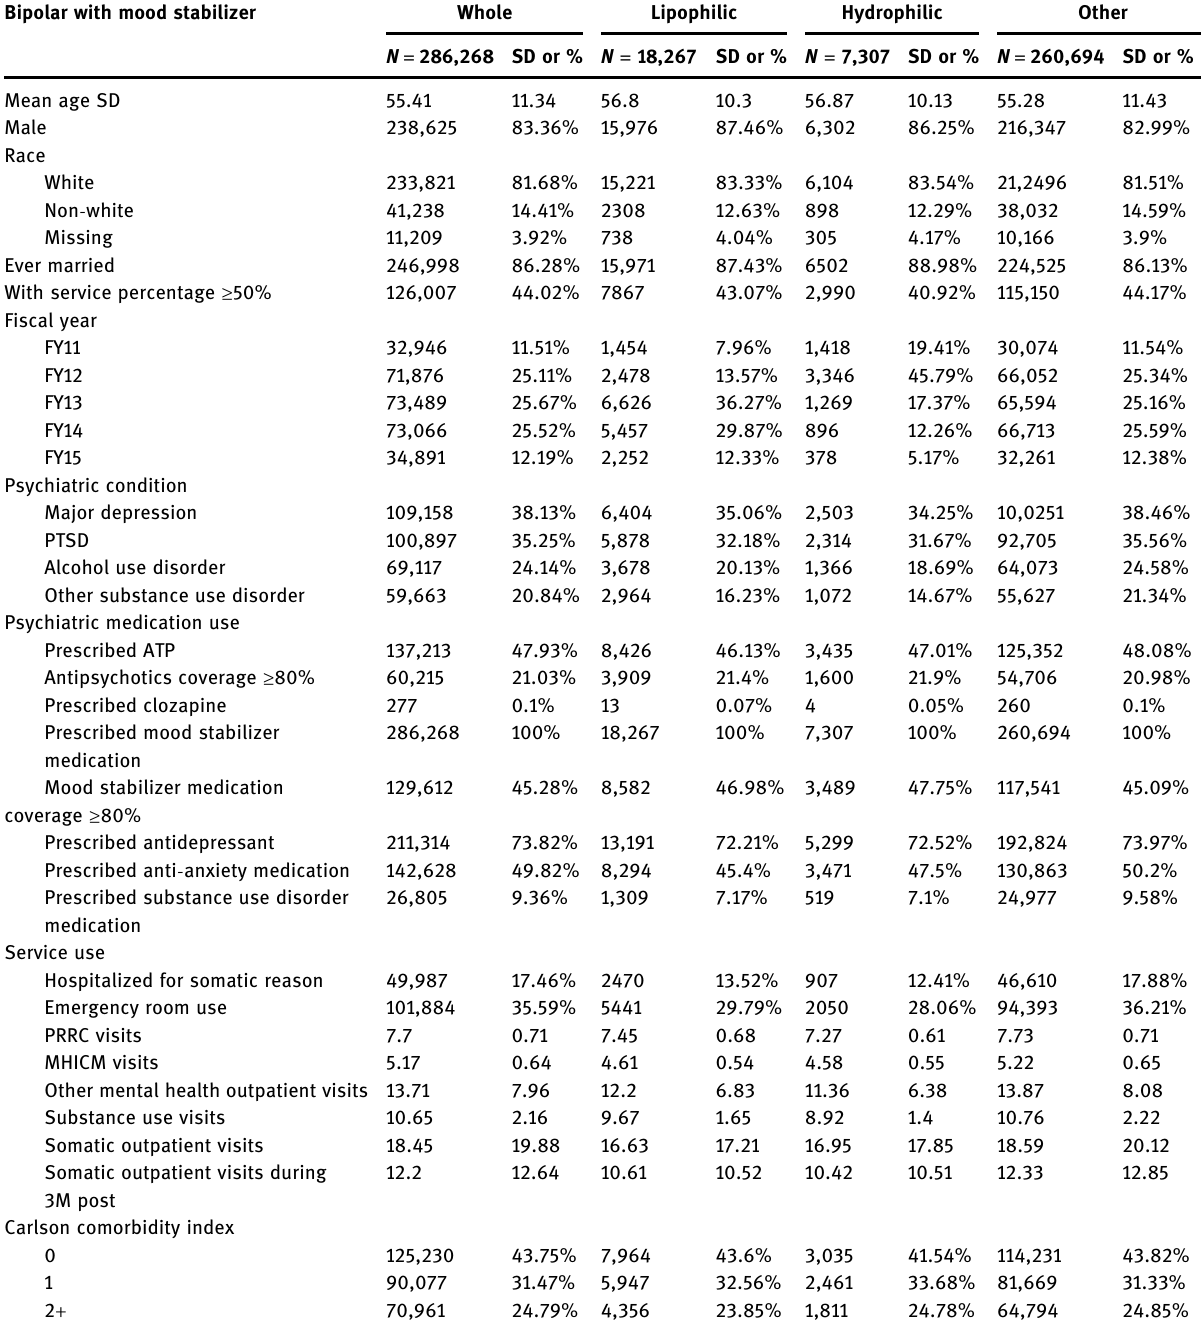
Table 3: Description of individuals with BD on mood - stabilizer medication Bipolar with mood stabilizer Whole Lipophilic Hydrophilic